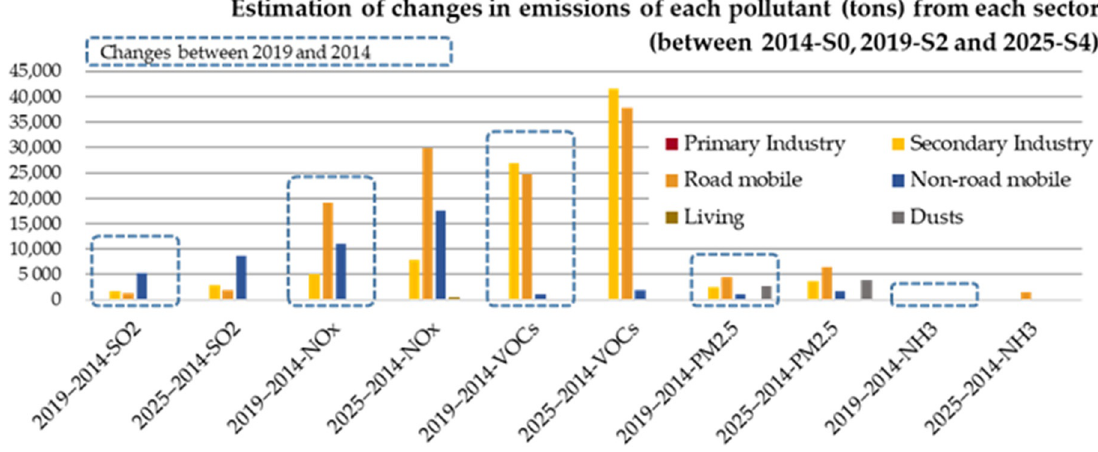
Figure 10. Expected reduction in emissions of air pollutants in 2019 and